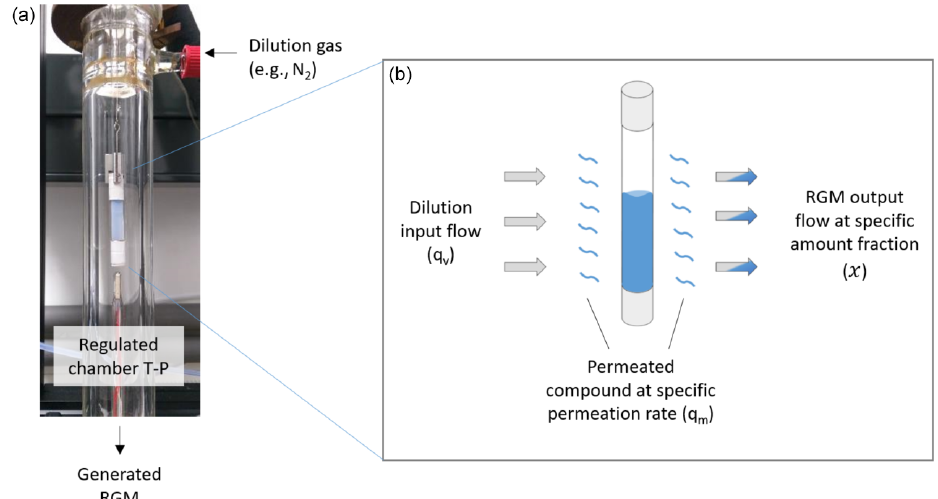
Figure 1. Principle of the permeation technique. (a) Example of a permeation tube placed in a chamber, where temperature ( T ), pressure ( P ), and dilution gas flow are regulated. (b) The permeation tube is filled with the selected pure compound in liquid form (blue). The compound (e.g., NH 3 ) permeates through the membrane (blue wavy lines) at specific permeation rates ( q m ), which are mainly temperature dependent. Gray arrows represent the dilution input flow ( q v ) of the gas (e.g., nitrogen or synthetic air) used to generate reference gas mixtures at different amount-of-substance fractions depending on the flow. The bicolor arrows represents the input flow ( q v ) of the generated reference gas mixture (RGM) at a specific amount-of-substance fraction ( χ ).